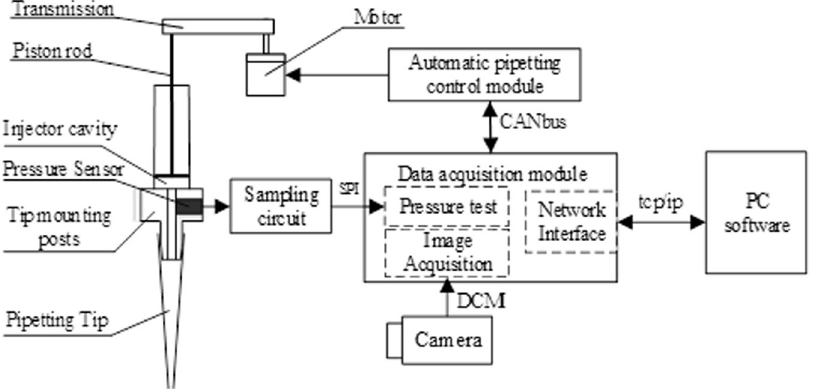
Figure 1. Block diagram of trace liquid detection